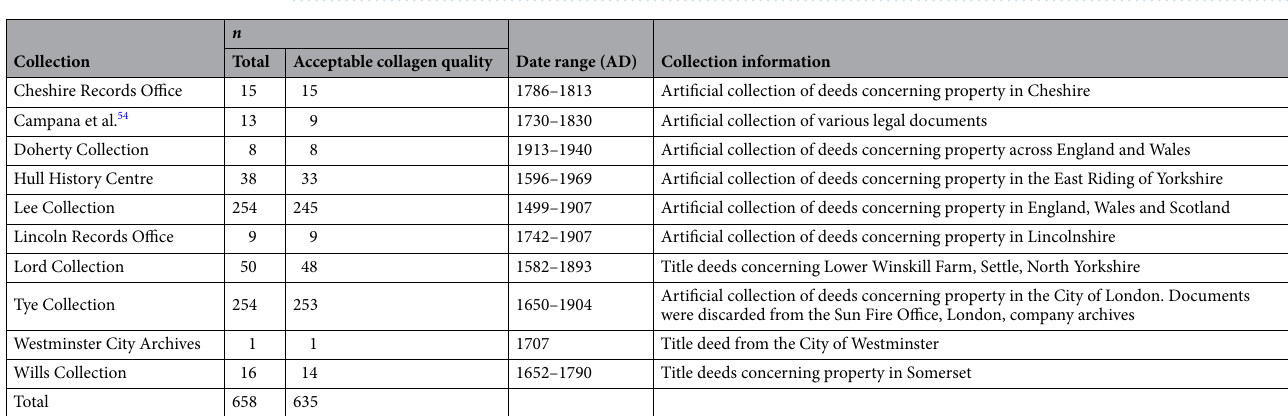
Table 1. Collection information of parchment documents analysed in the study ( n = number of samples). Collagen quality criteria outlined in the methods section. The artificial collections contain documents of different provenance, while the others have grown organically around a single property.